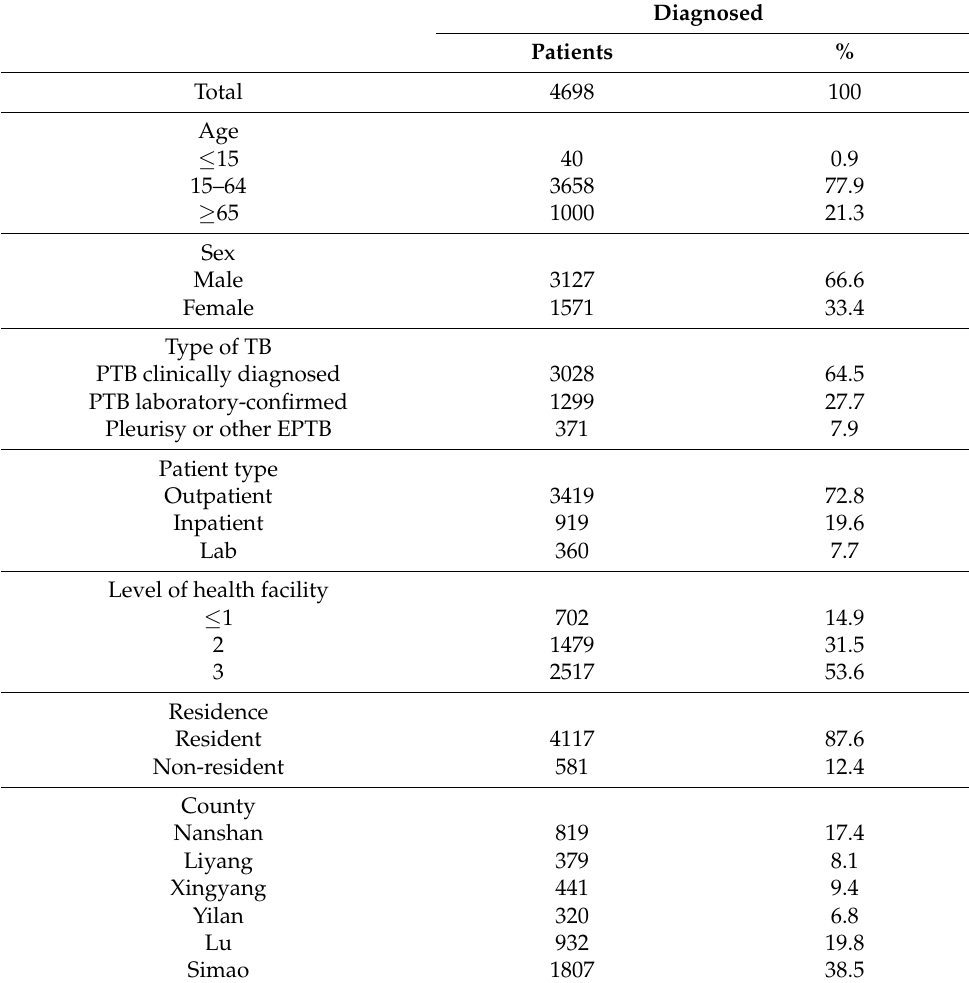
Table 1. Characteristics of diagnosed tuberculosis (TB) patients in six counties in